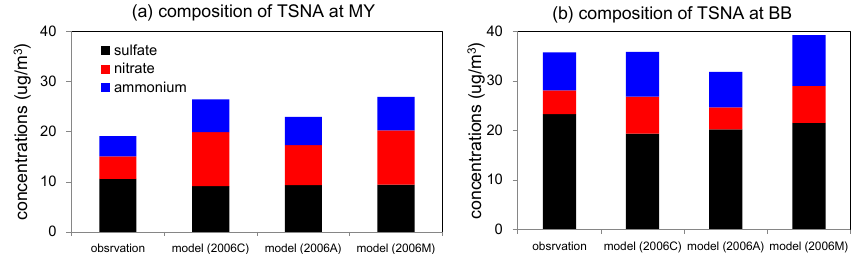
Fig. 8. Observed and simulated annual mean SNA composition and concentrations at the MY (a) and BB (b) sites. Model results from 2006C, 2006A and 2006M simulations are